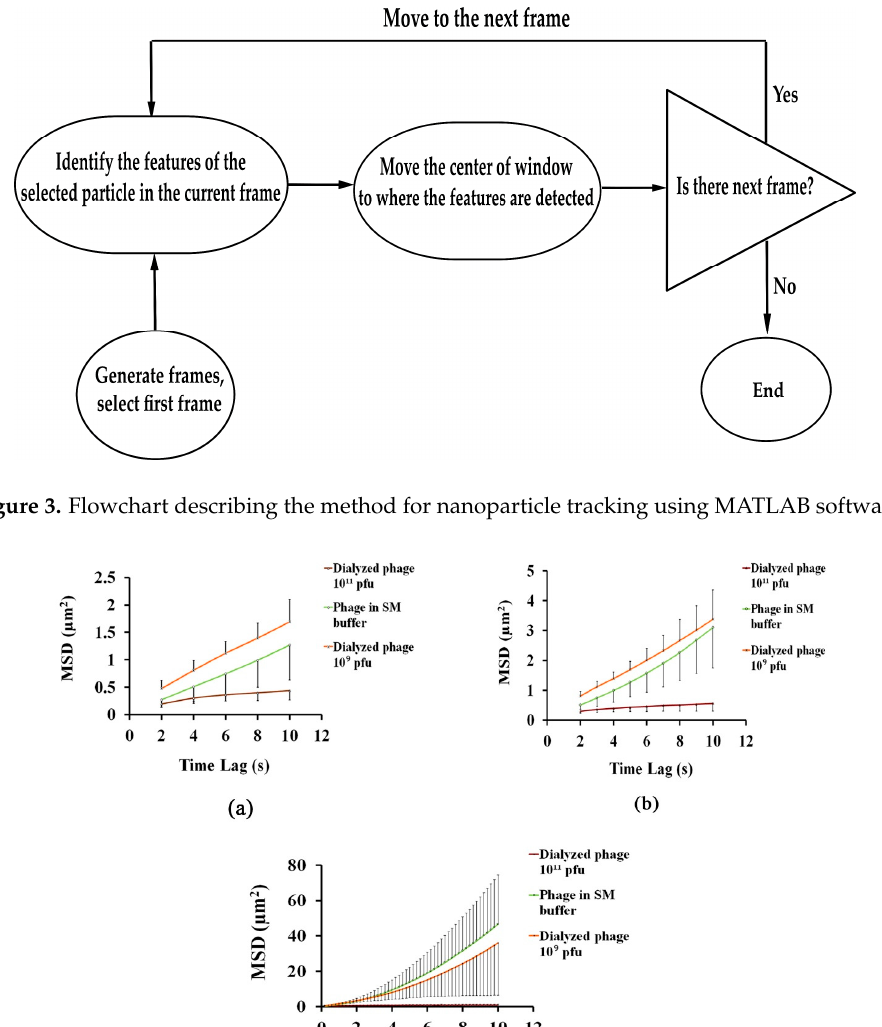
Figure 4. Mean square displacement of phage nanoparticles under different conditions with ( a ) τ = 5; ( b ) τ = 10; and ( c ) τ = 50.